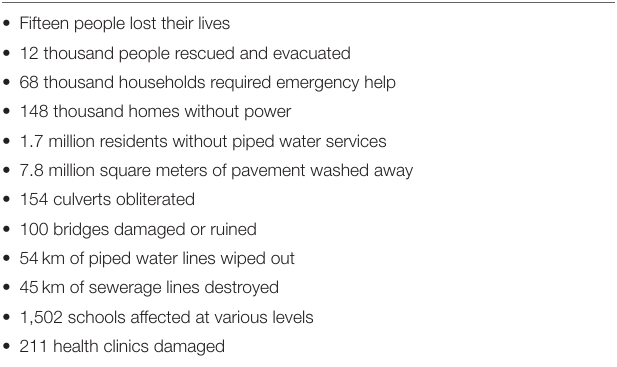
FIGURE 7 | Damages to housing. TABLE 2 | Impacts and damages of Hurricane Alex (2010), Monterrey and Nuevo León, Mexico.